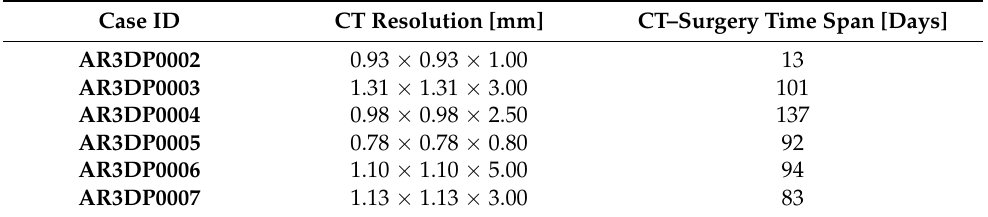
Table 2. Resolution of the CT scan acquired for each patient and time span between image acquisition and